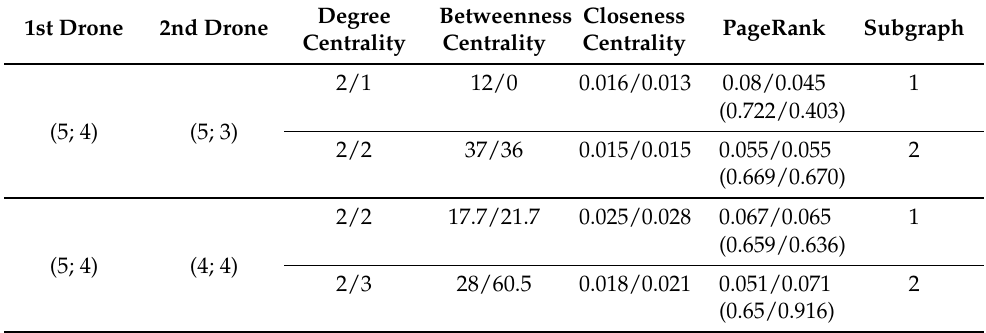
Table 4. Centrality measures computed for two optimal positions of the drones. The respective values for the first and the second drone are separated by a slash: C x ( δ 1 ) / C x ( δ 2 ) . Normalized values of PageRank measures are shown in round